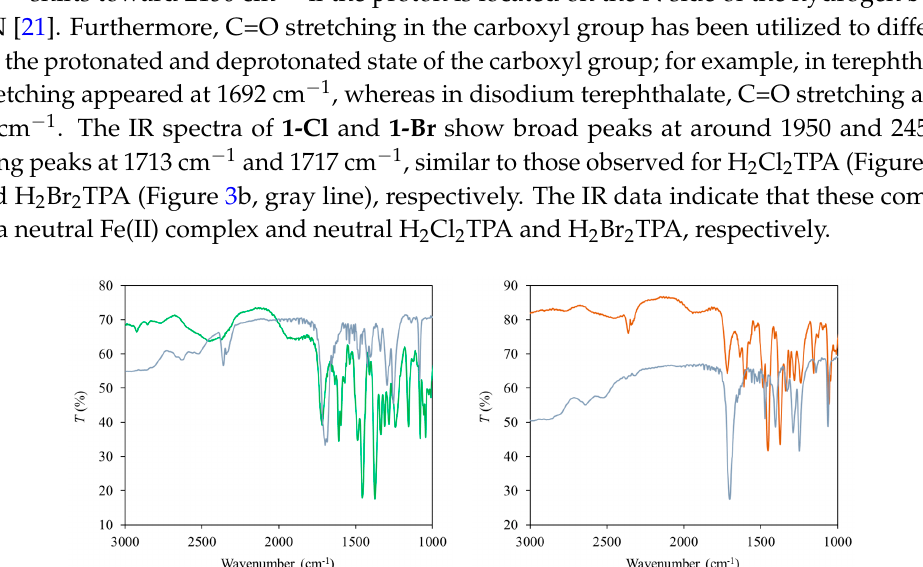
Figure 2. The π - π interaction between [Fe(L) 2 ] and H 2 Cl 2 TPA in 1-Cl .